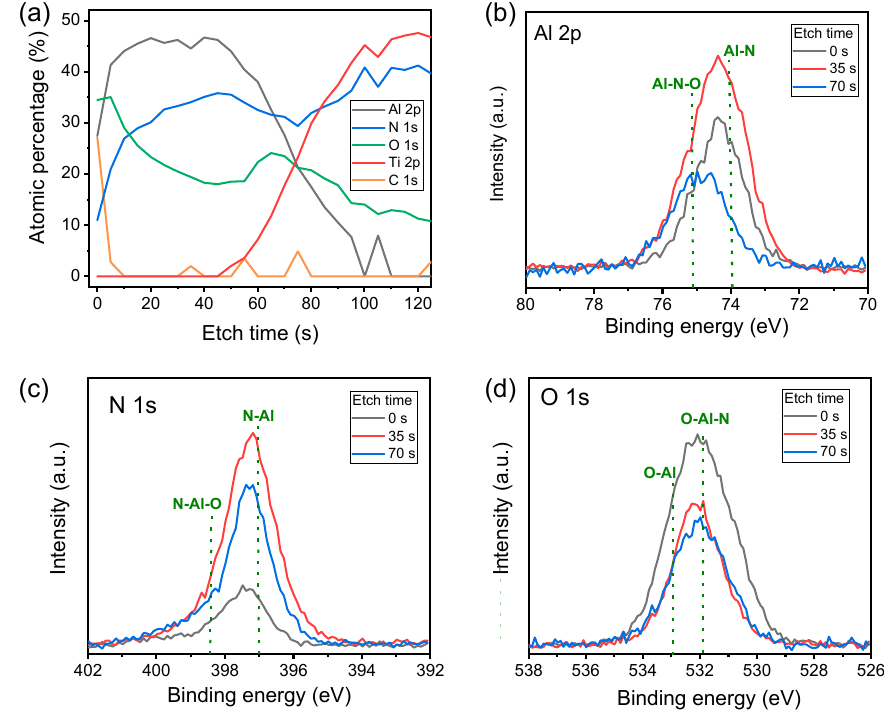
Figure 1. XPS analysis of AlN / TiN layers: ( a ) Depth profiles for elements Al, N, O, Ti, and C; ( b ) Al 2p, ( c ) N 1s; ( d ) O 1s spectra.